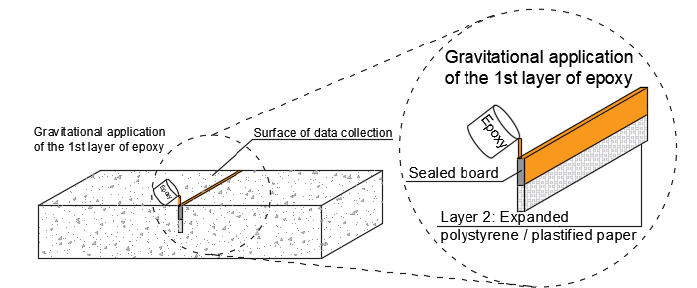
Figure 3. 1 st stage of resin application